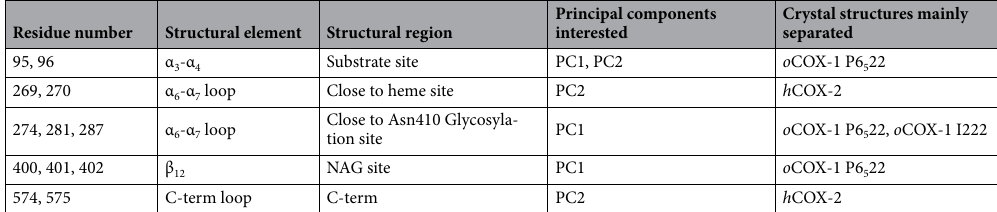
Table 3. Key residues determined by backbone dihedral angles comparative analysis applied on h COX-1, o COX-1, and h COX-2 crystal structures. In the table are reported: the residue number, the structural elements and the structural region where the residues are located, the principal components having high loadings values in the specific residue range (fourth column) and the crystal structures mainly separated by applying PCA to the specific residue range (last